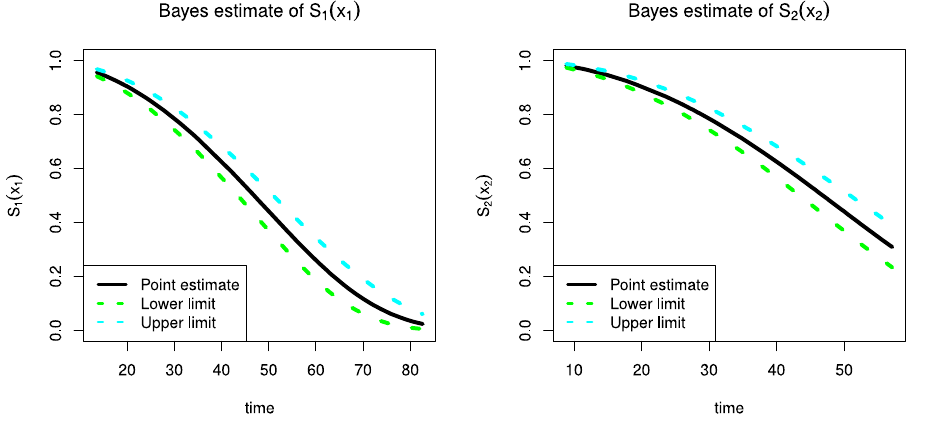
Figure 5. Convergence of MCMC results for progressive-stress model.